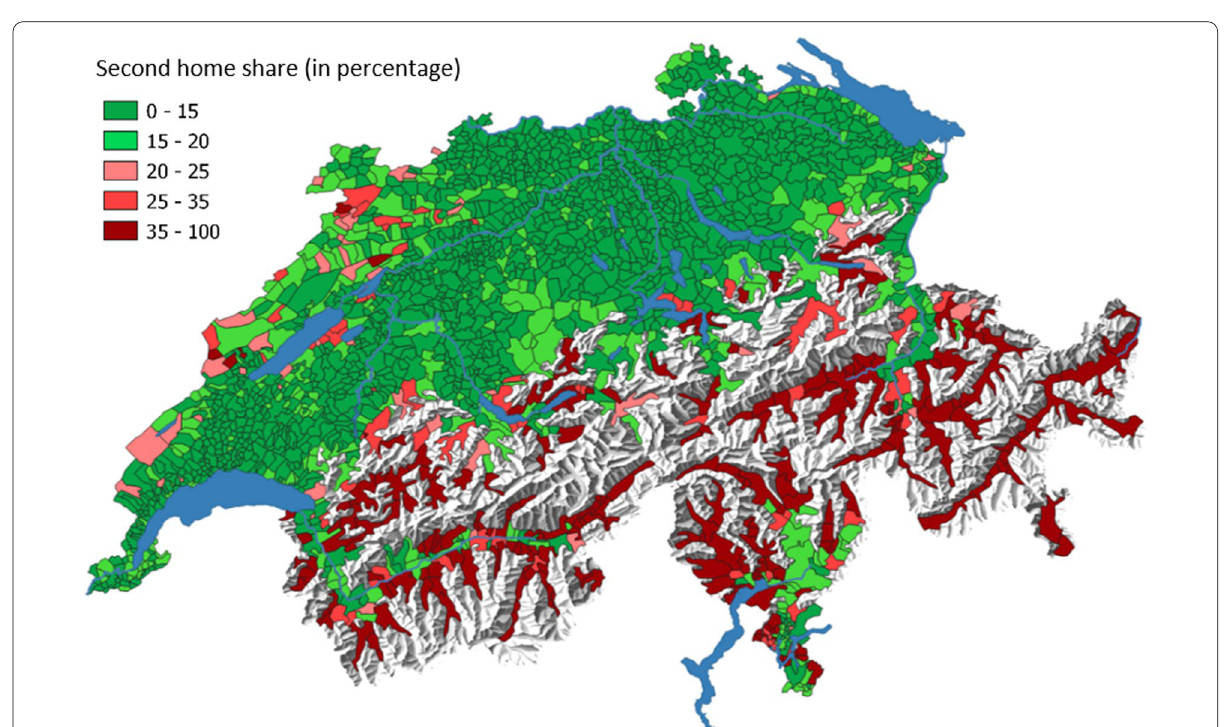
Fig. 1 Second home shares by municipality (vegetation area) in Switzerland. Source : Author’s illustration of the FSO Second Home Data of